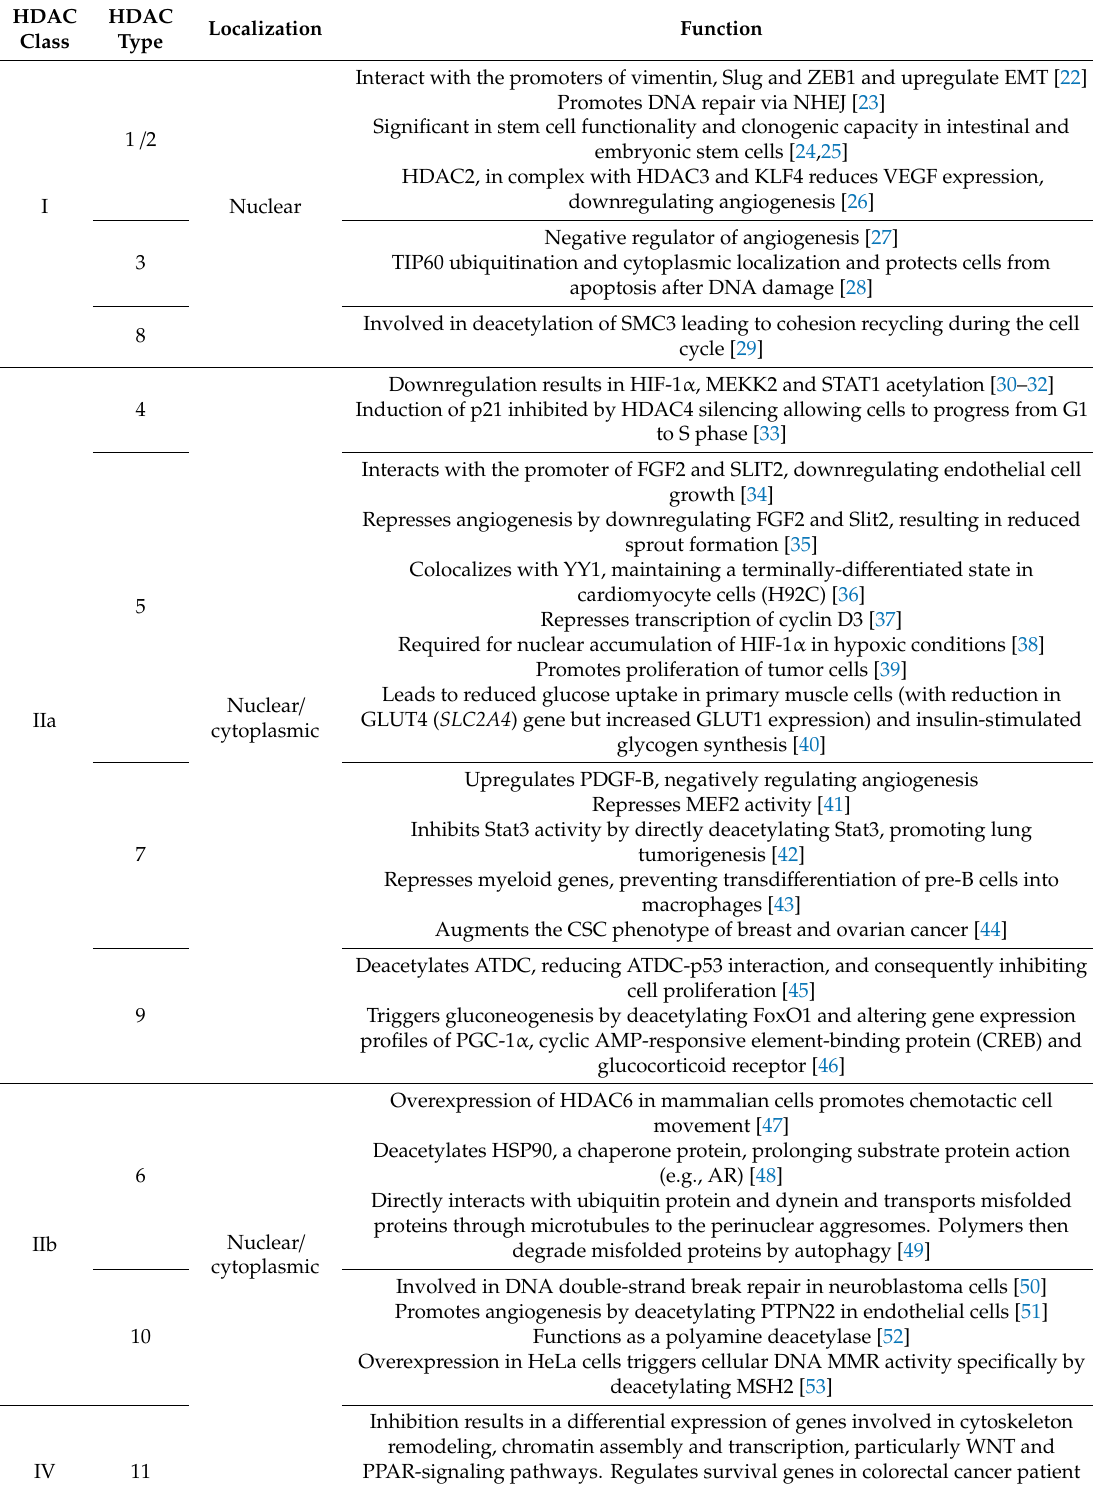
Table 1. Localization and function of di ff erent classes of